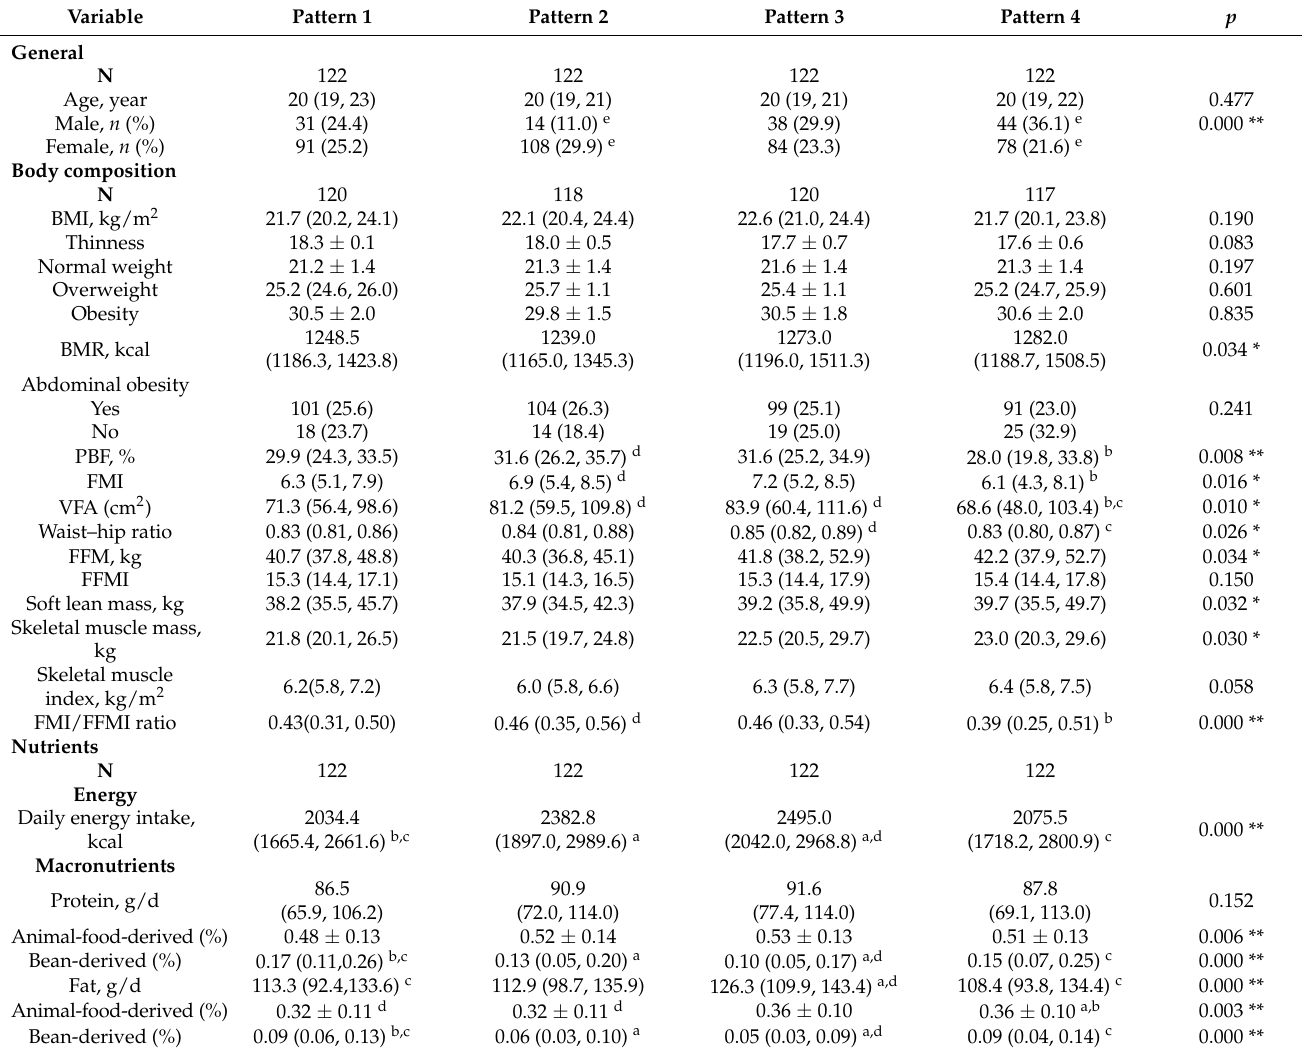
Table 3. Overall sample characteristics stratified by dietary